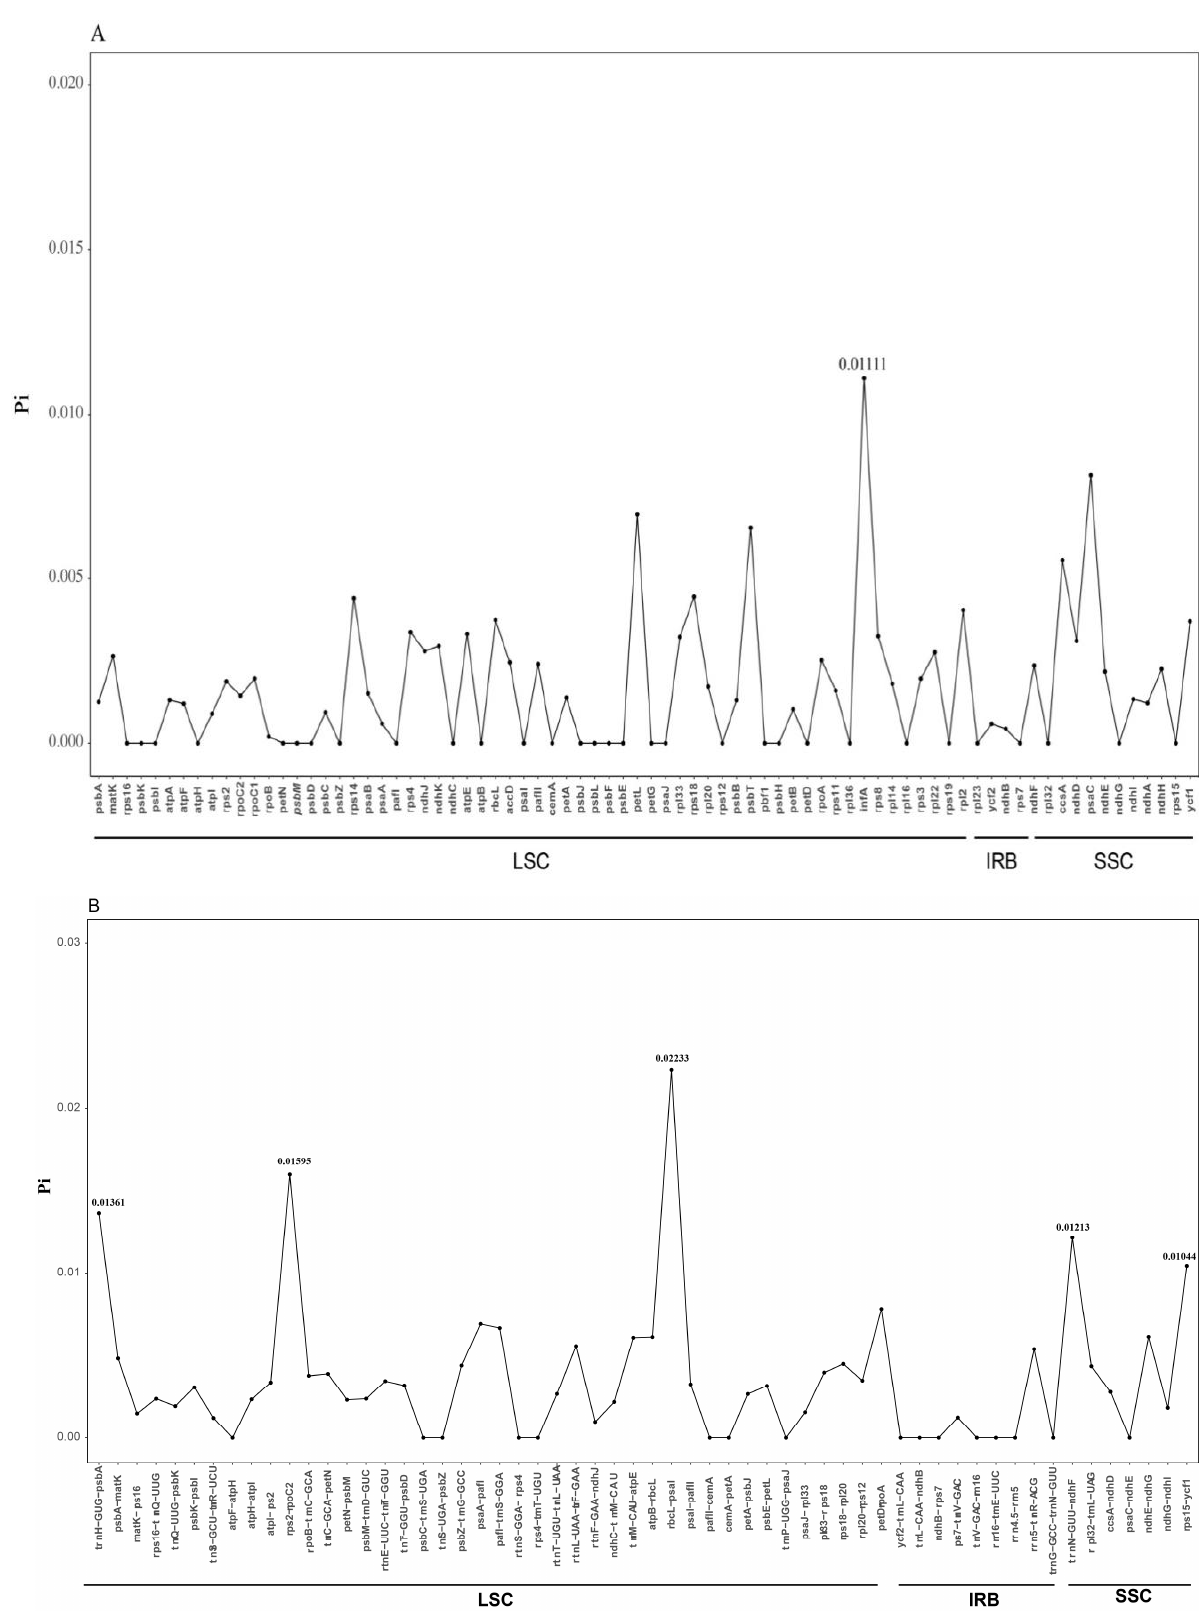
Figure 6. The nucleotide variability (Pi) values were compared among L. acuminata , L. similis, and L. japonica . ( A ) CDS region; ( B ) Intergenic spacer region.